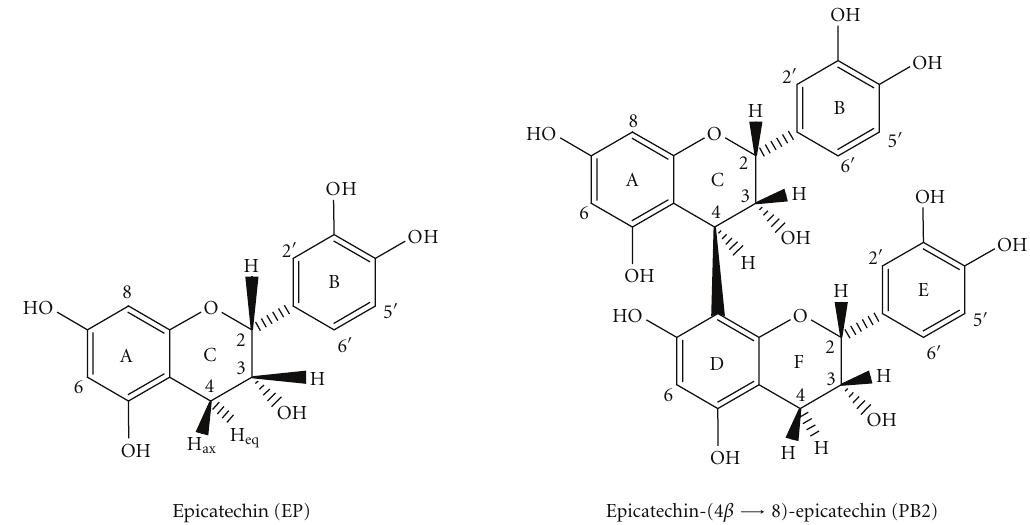
Figure 1: Chemical markers of the G. ulmifolia dried